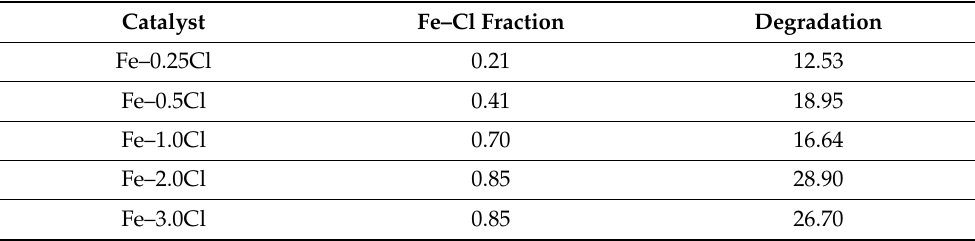
Table 7. Chlorine fraction and degradation in the visible-light region.